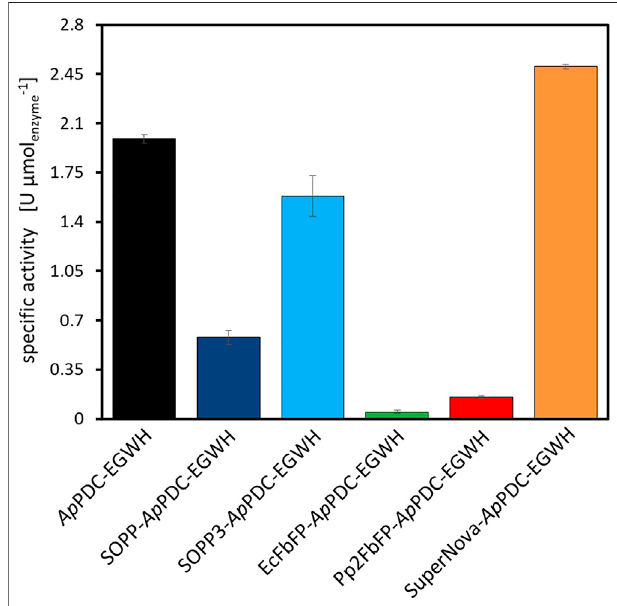
FIGURE 6 | Initial rate of the photosensitizer fusion enzymes in dark conditions compared to the untagged Ap PDC-EGWH. For fusions with EcFbFP and Pp2FbFP the activity of the insoluble protein aggregates was